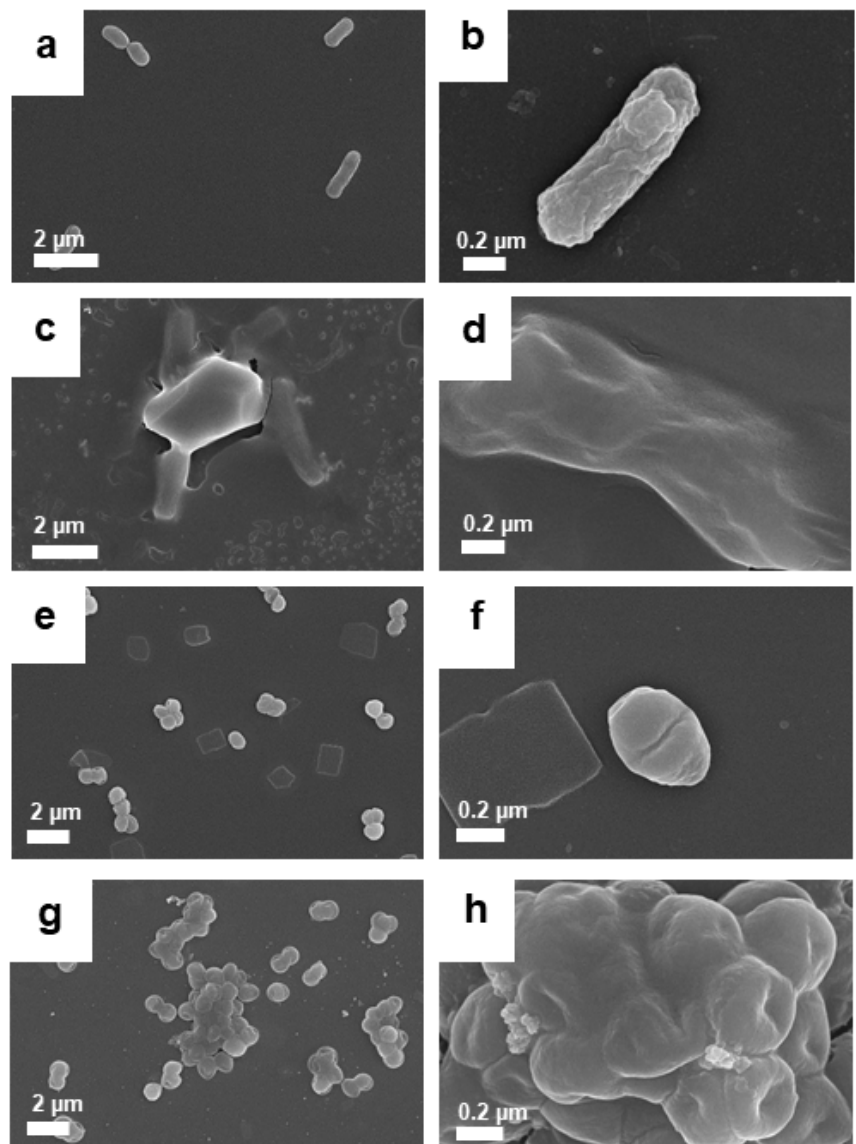
Figure 13. FESEM images of E. coli before ( a , b ) and after treatment ( c , d ) with GO–Ag NPrsms, and S. aureus ( e , f ) before and after treatment ( g , h ) with GO–Ag NPrsms.